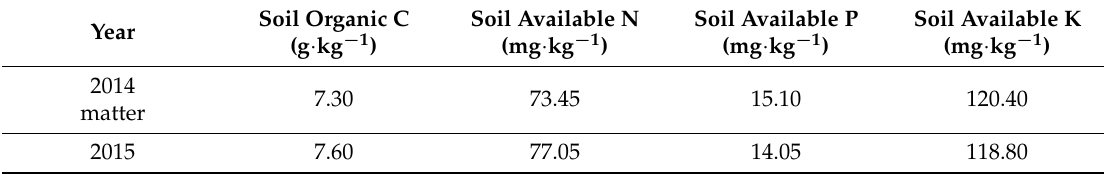
Table 1. Soil properties in 2014 and 2015